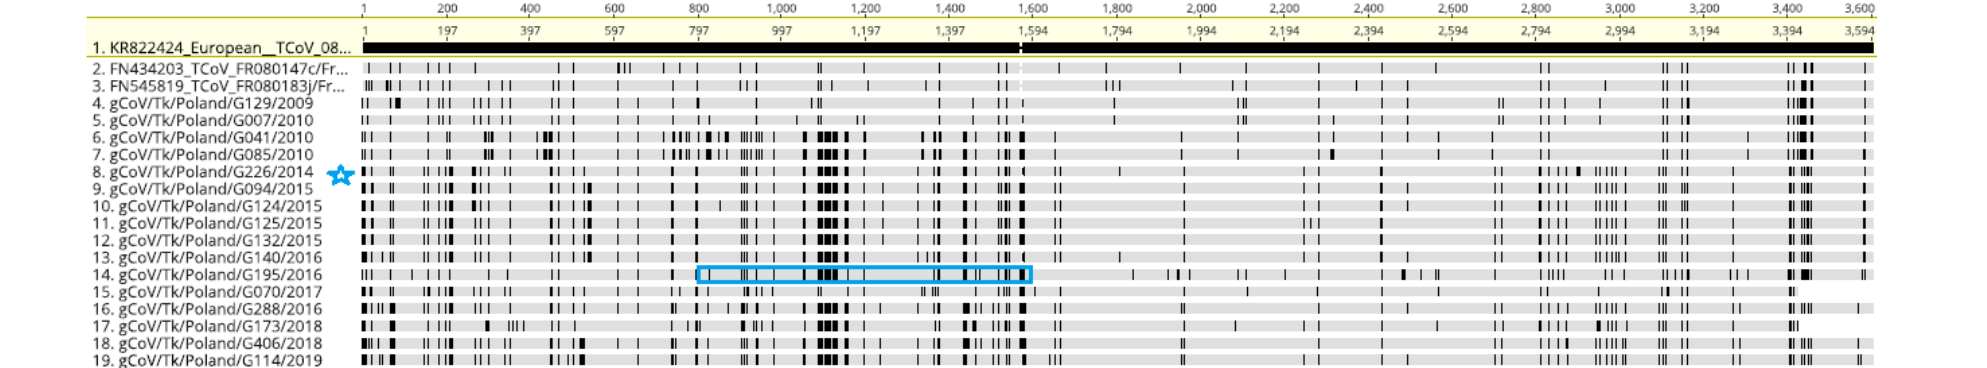
Figure 3. This is a figure alignment of the S gene sequences of Polish TCoVs and two other strains from France performed using MAFFT. The S gene sequence of TCoV 080385d/France/2008 (KR822424) was used as the reference sequence. Vertical lines indicate the single nucleotide polymorphism compared with the reference sequence. Blue box = recombination of G195/2016 with G226/2014 (strain marked with a blue star).